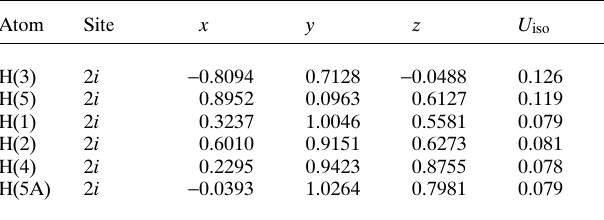
Table 2. Atomic coordinates and displacement parameters (in Å 2 )